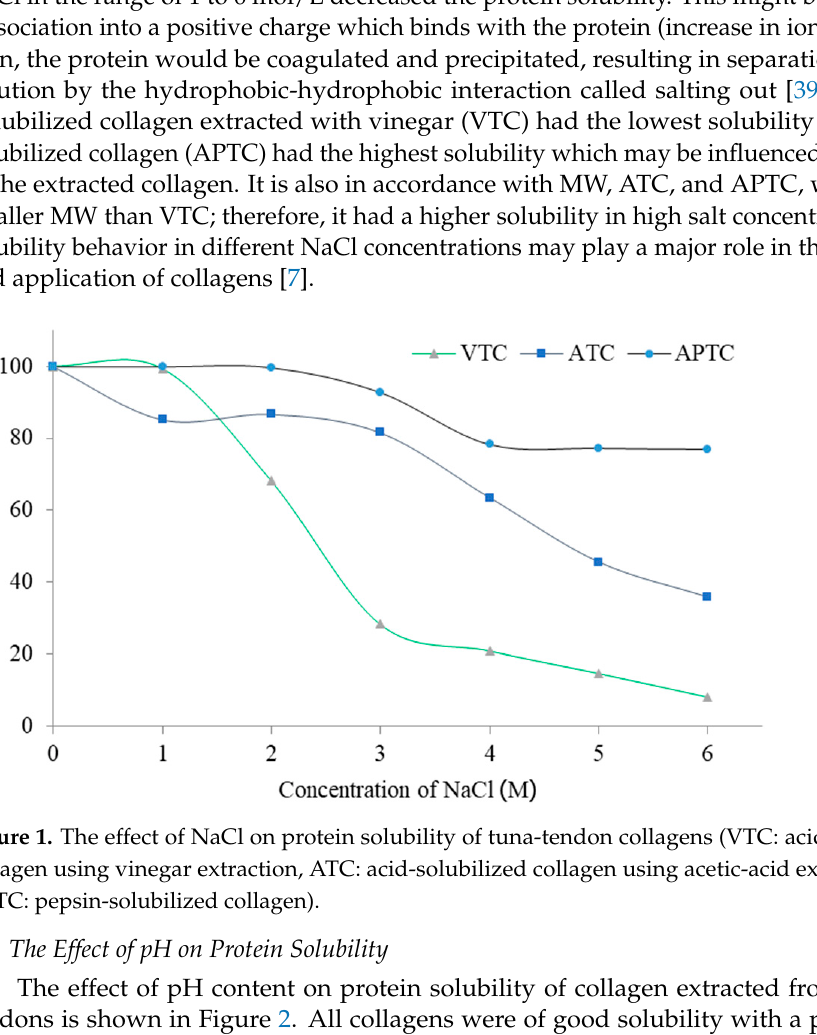
Table 3. The soluble-protein content of tuna-tail-tendon collagens. Tuna Tail Tendon Collagen ATC